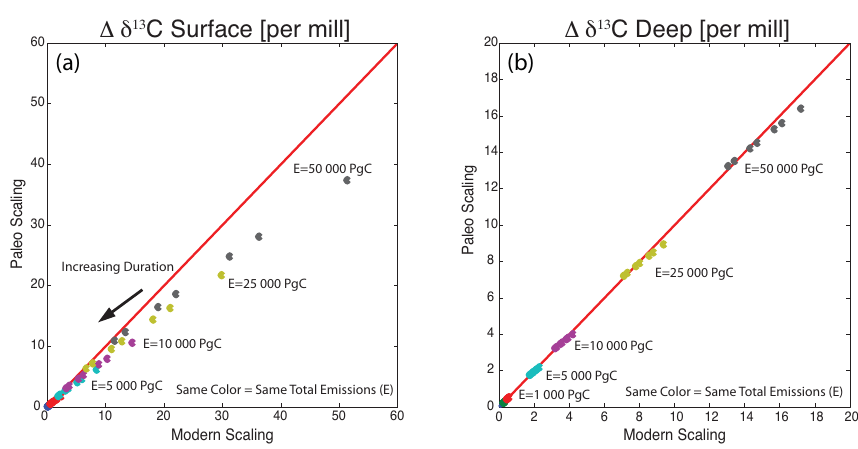
Figure 15. Correlation between peak perturbations for modern and paleo-scalings. (a) Surface-ocean carbon-13 anomalies. (b) Deep-ocean carbon-13 anomalies. Same color denotes same total